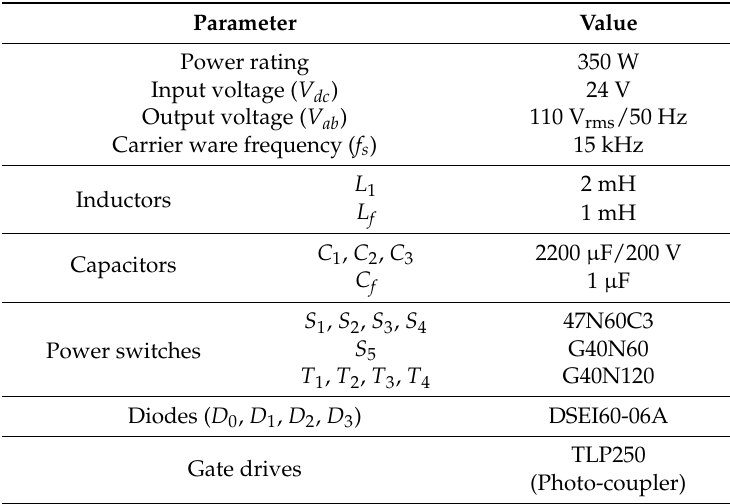
Figure 8. A laborotary prototype of single-phase NLBI. Table 3. Operating Parameters for the Proposed Inverter.